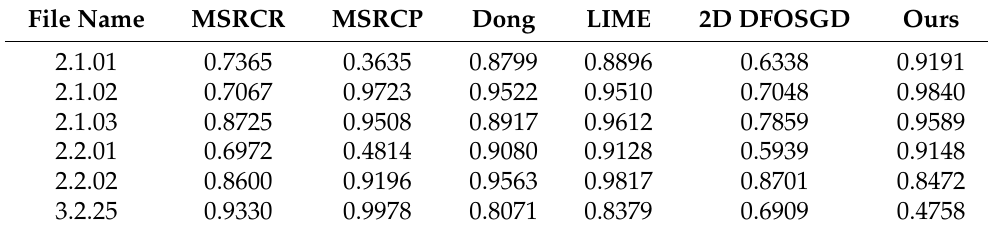
Table 3. The comparison of SSIM.